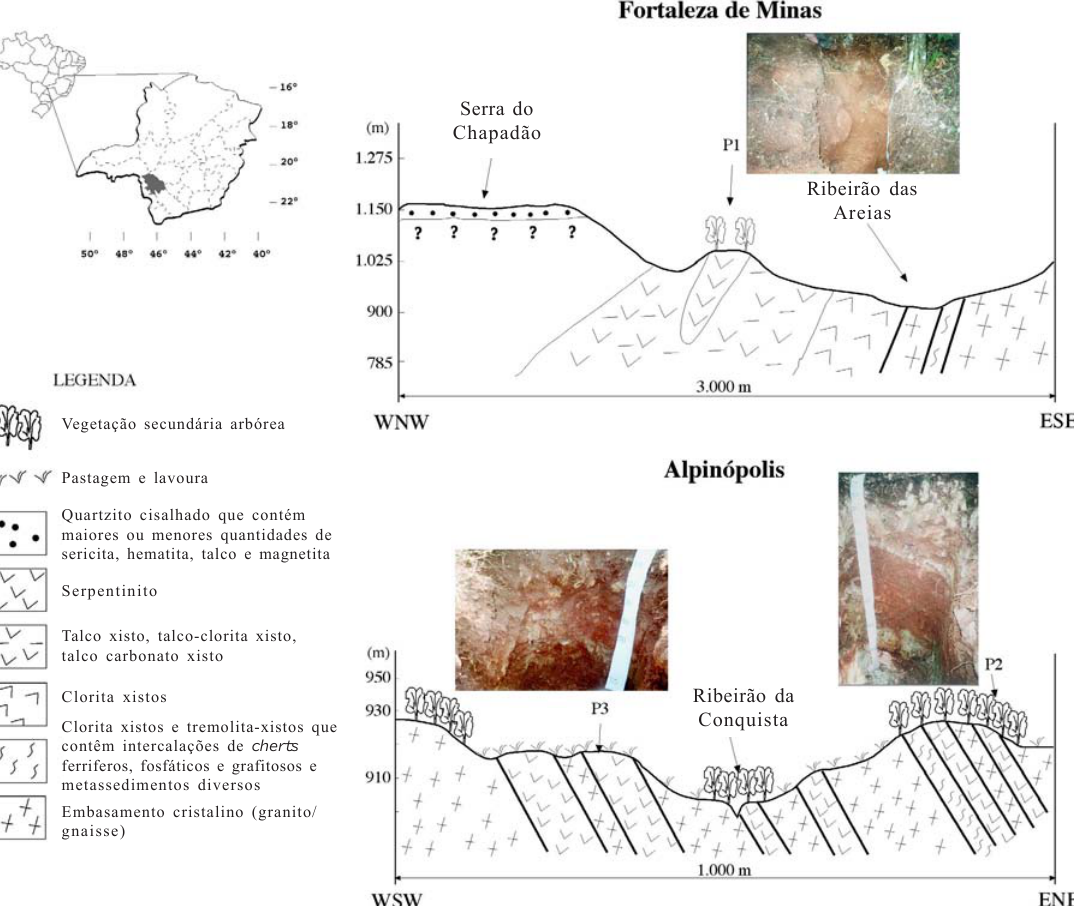
Figura 1. Localização da área de estudo e representação esquemática do relevo, litologia e situação dos perfis